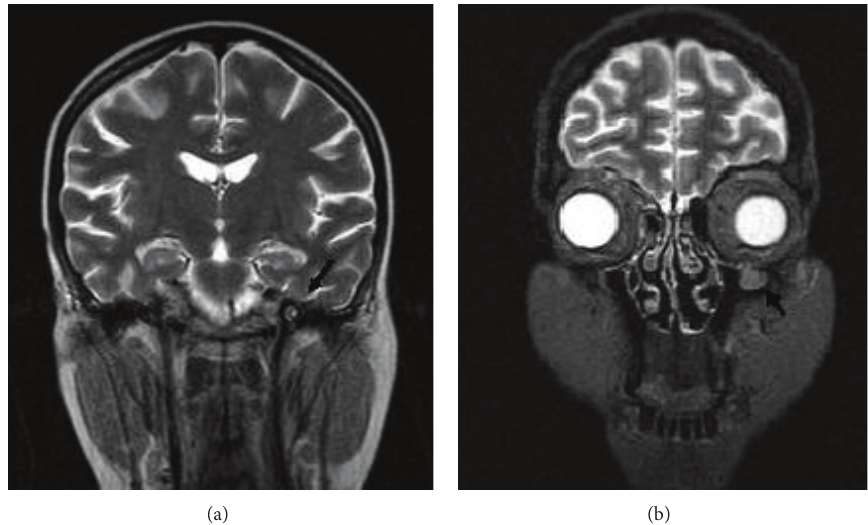
Figure 1: The cranial and orbital sagittal T2-weighted magnetic resonance image revealing a thickening of the third division of trigeminal nerve (a) and a soft tissue development of one centimeter diameter in the roof of left maxillary sinus (b).